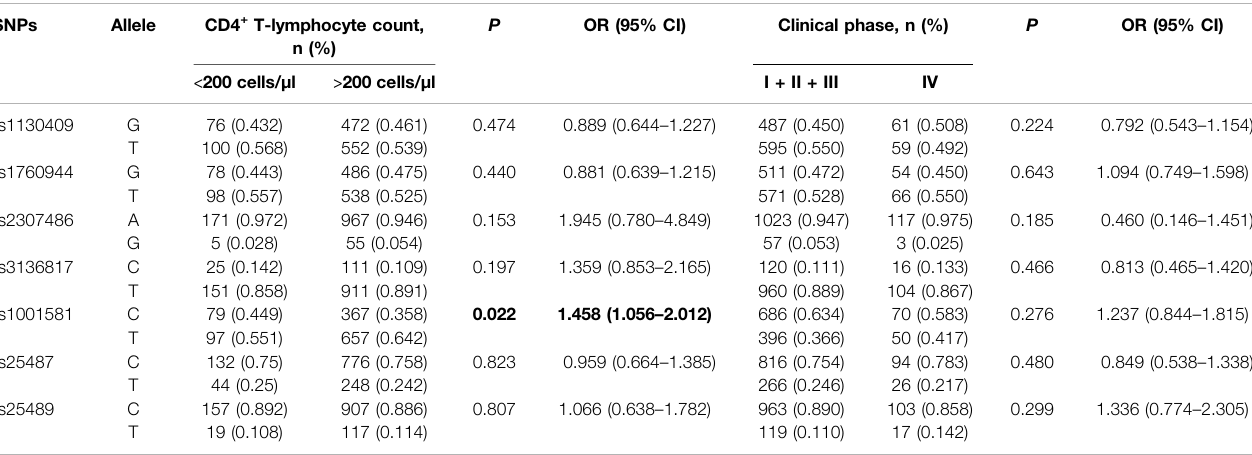
TABLE 3 | Association between the 7 SNPs and the clinical features of AIDS. P OR (95% SNPs Allele CD4 + T-lymphocyte count, n (%)